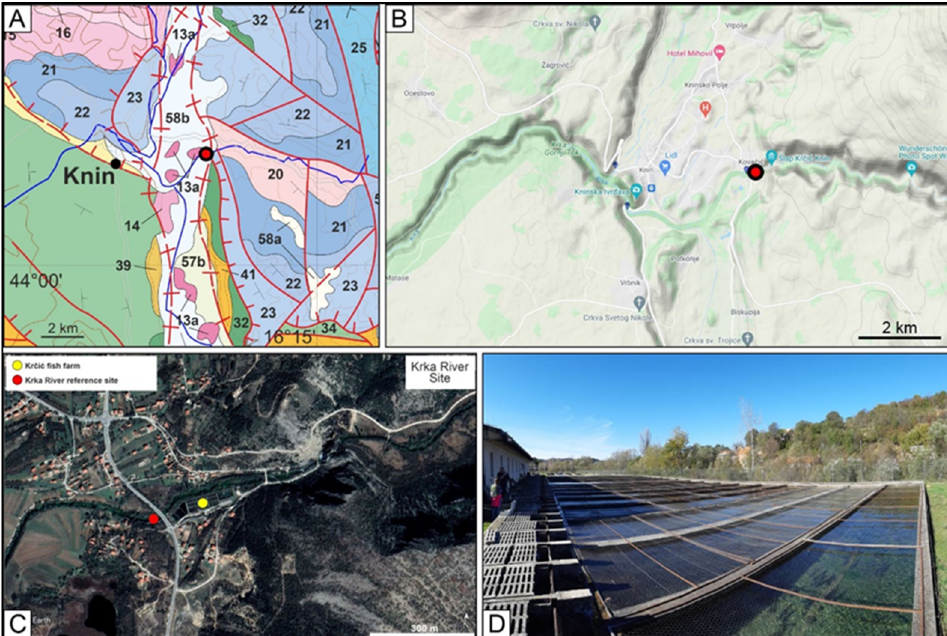
Figure 3. ( A ) Geological map of the Krka River study site: 13a—Permian evaporites and clastites; 14—Triassic clastites; 15—Triassic carbonates; 16—Triassic clastic and pyroclastic deposits; 20—Triassic dolomites; 21–24—Jurassic limestones and dolomites; 32—Cretaceous limestones and dolomites; 34—Cretaceous limestones; 39—Paleocene-Eocene limestones; 41—Eocene-Oligocene car- bonate deposits; 57b—Holocene lake deposits; 58a—Holocene alluvial deposits; blue lines—streams and rivers; red lines—main faults; thin brown lines—isohipses (after [35,36]). Red-black dot repre- sents sampling locations. ( B ) Topographic map of the Krka River study site wider area. Red-black dot represents sampling locations. The altitude of the Krka River site is 220 m above the sea. Maximal altitude here is 800 to the east. ( C ) Location of the Krka River and the Krka fish farm sampling sites (after Google Earth). Red and yellow dots represent sampling locations. ( D ) Krka fish farm with concrete basins. The right-most basin shown is a sedimentation tank.